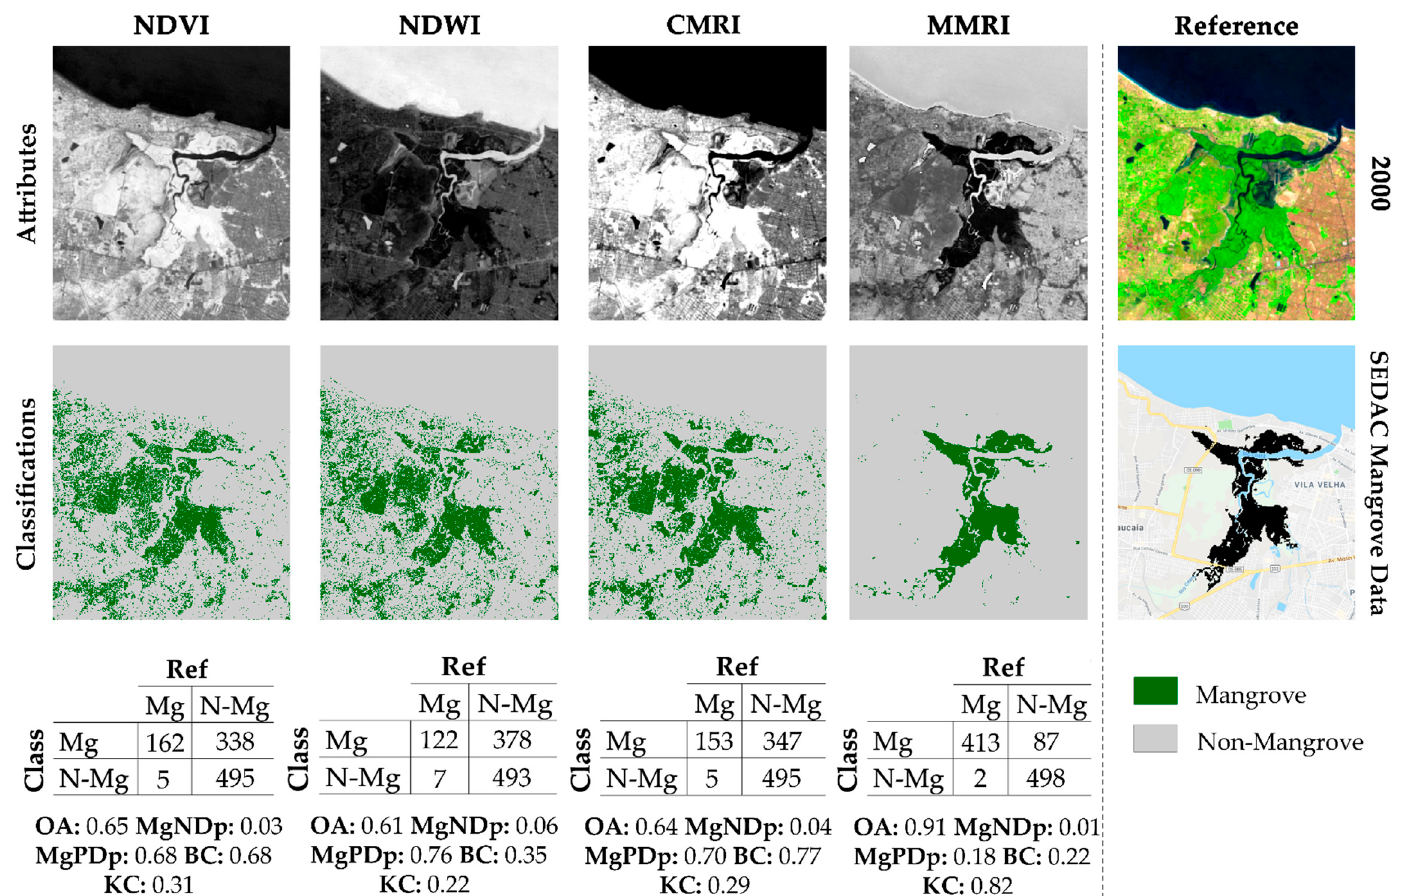
Figure 6. The first row shows the visual aspects of each index—NDVI, NDWI, CMRI and MMRI. The second row shows the classification results. The bottom row shows the contingency tables, where Mg stands for the mangrove class and N-Mg stands for the non-mangrove class. OA stands for overall agreement, MgPDp indicates mangrove positive disagreement proportion, MgNDp refers to mangrove negative disagreement proportion, KC means the kappa coefficient and BC denotes the Bhattacharya coefficient.